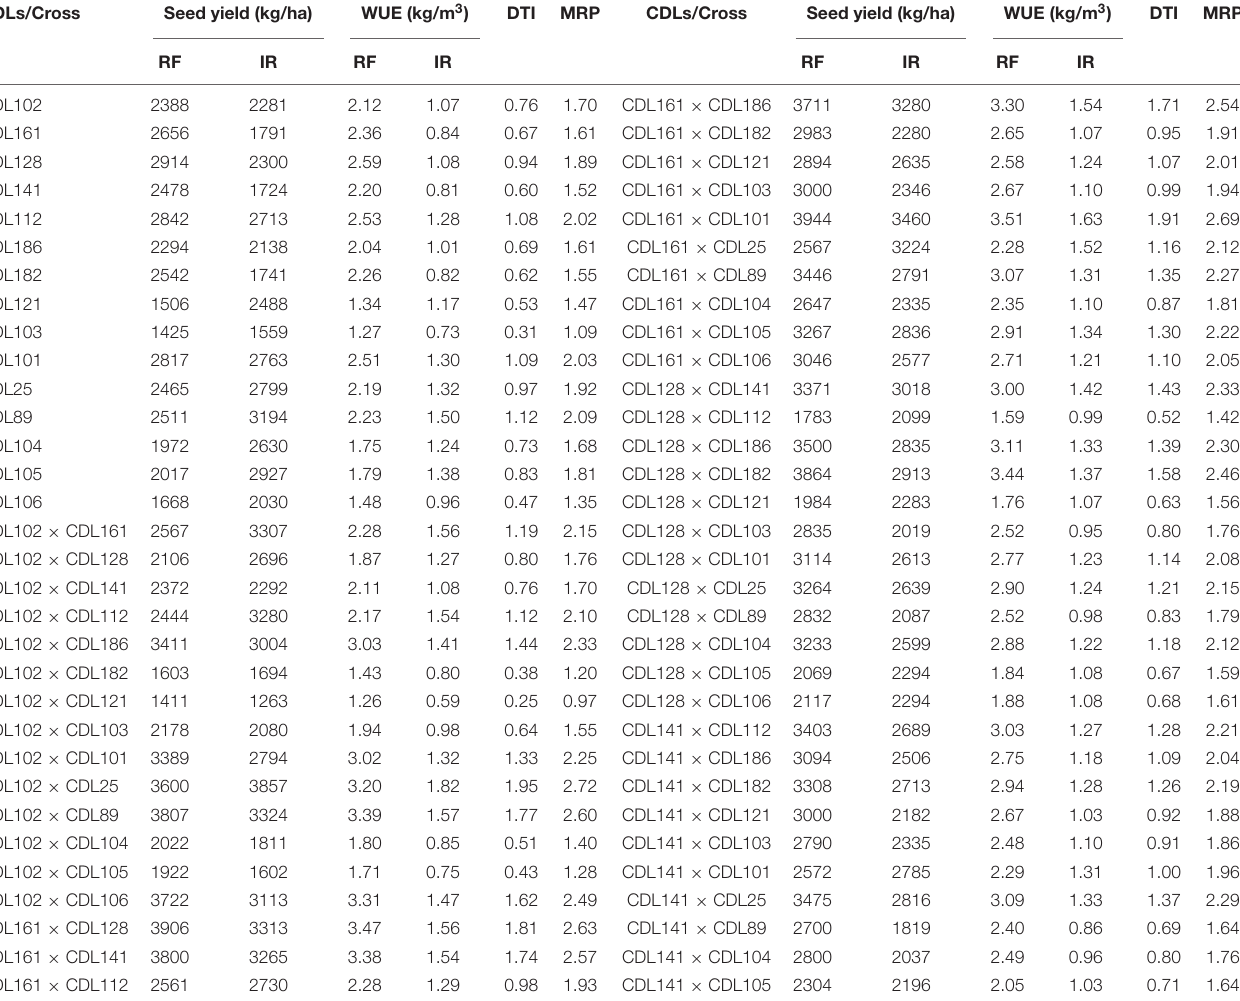
TABLE 8 | Water use efficiency, drought tolerance indices, and seed yield performance of CDLs and their F 1 hybrids under rainfed (RF) and irrigated (IR) conditions. CDLs/Cross Seed yield (kg/ha) WUE (kg/m 3